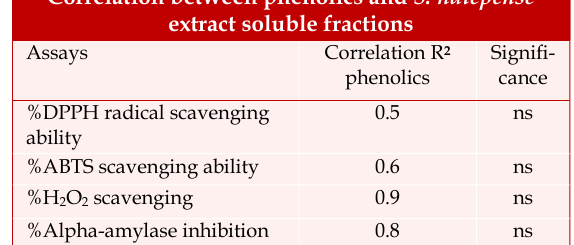
Correlation between phenolics and S. halepense